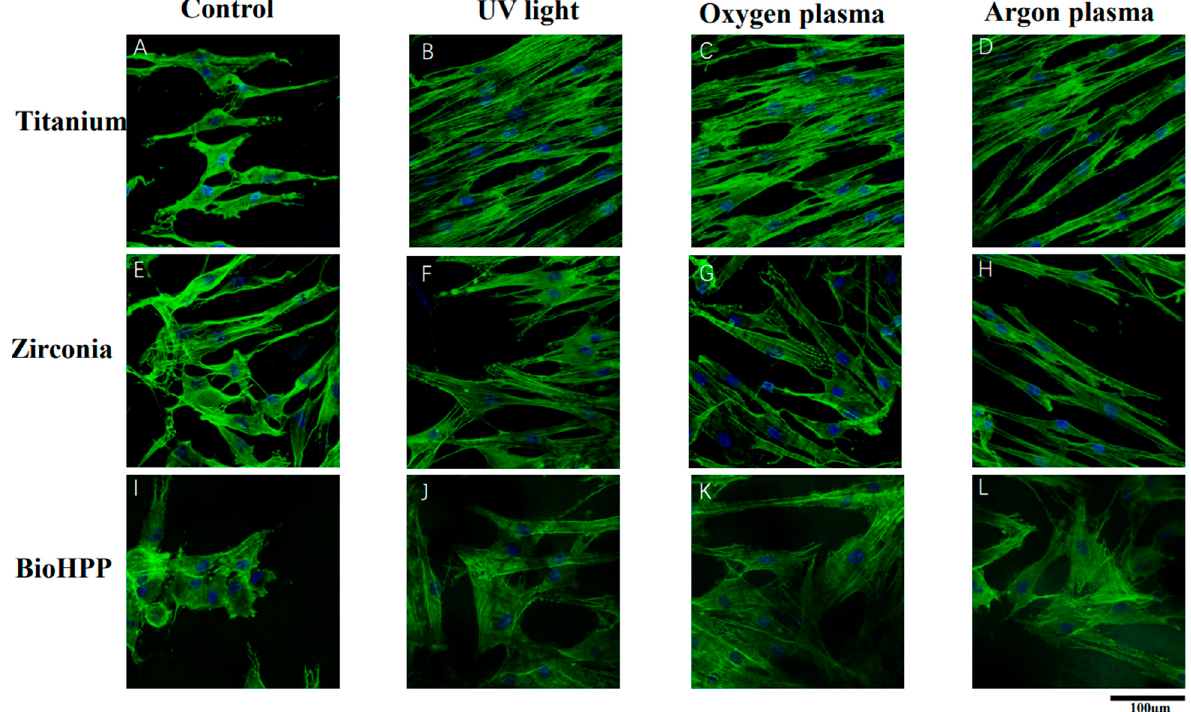
Figure 1. Cell attachment and morphology on different surface treated titanium, zirconia and BioHPP after 24 h. Representative examples of cytoskeletons stained with phalloidin after 24 h of incubation on controls ( A , E , I ), UV light treated ( B , F , J ), oxygen plasma treated ( C , G , K ) and argon plasma treated ( D , H , L ) surfaces of titanium, zirconia and BioHPP using confocal microscopy with 60-fold objective lens. The actin cytoskeleton was marked phalloidin (green color) and the nucleus by DAPI (blue color). Compared to control groups, cells were more extended and flattened with a more widely spread cytoskeleton possessing elongated cytoplasmic extensions on UV light, oxygen and argon plasma treated surfaces.